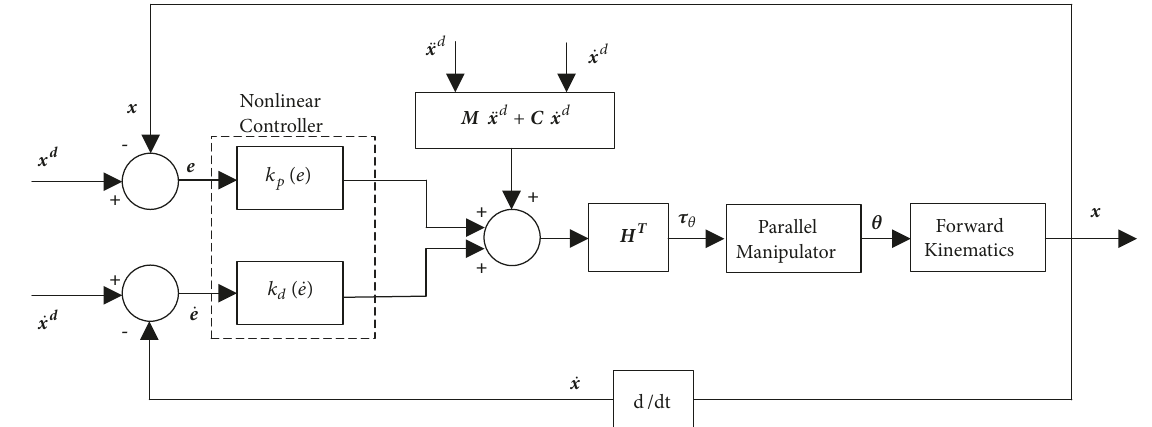
Figure 7: Block diagram of ANPD controller.